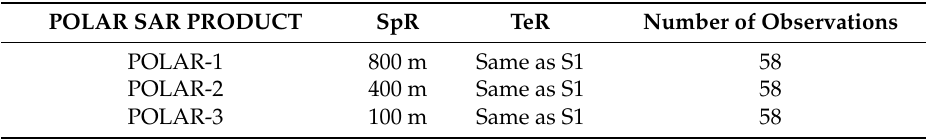
Table 3. POLAR SAR product specifications considered in the SM-DA exercises, and total number of POLAR SAR-like observations that were assimilated.